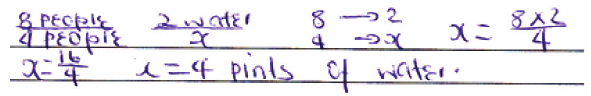
FIGURE 2: Response of Learner 13 to Question